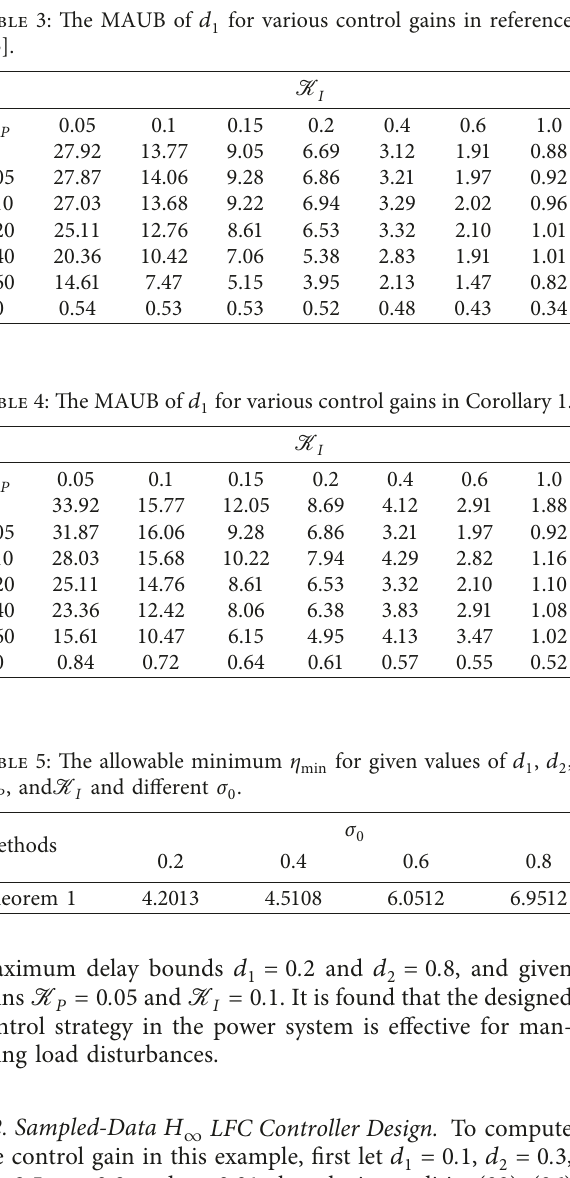
for various control gains in reference 1